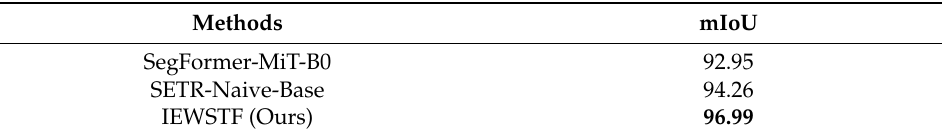
Table 2. Comparison of mIoU for all methods.